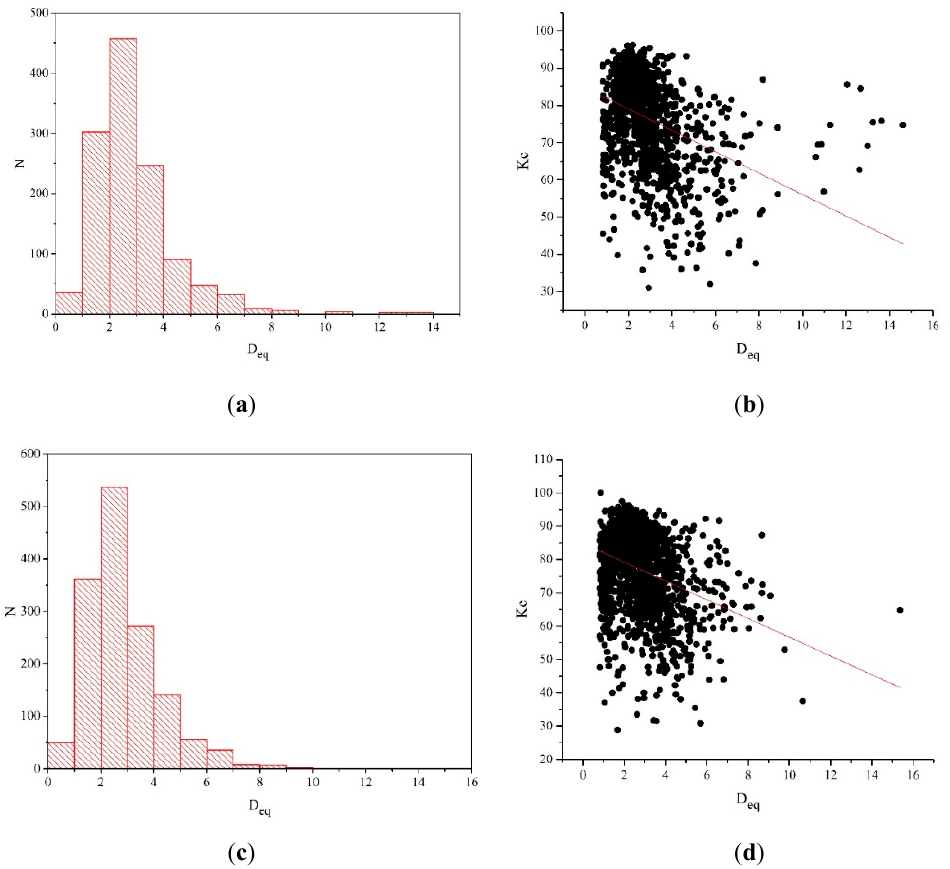
Figure 6. Distribution histograms on the diameters and shape coefficients of the dimples found on the steel fracture surface of the gas pipelines: ( a , b ) “Novopskov ‐ Aksai ‐ Mozdok” (Nevinnomysskaya CS); ( c , d ) “Gorky ‐ Center” (Gavrilovskaya CS).